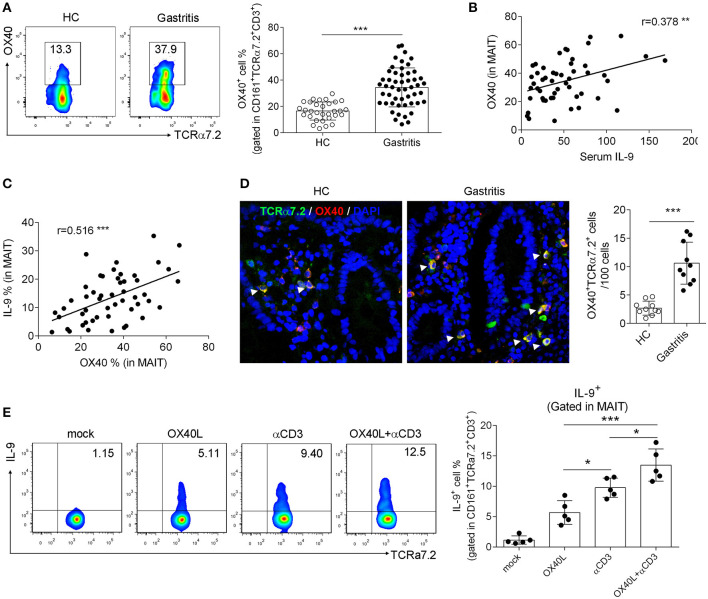
OX40 promoted IL-9 production by gastric mucosal MAIT cells in H. pylori-positive patients. Biopsies from gastric mucosa of H. pylori-positive patients (n = 51) and healthy controls (n = 35) were collected. (A) OX40 expression in MAIT cells was determined by flow cytometry. The correlations (B) between OX40 expression (in MAIT cells) and serum IL-9 level, and (C) between the percentage of OX40+ and IL-9+ MAIT cells were analyzed, respectively (n = 51). (D) Co-localization of OX40 and MAIT cells was assessed by immunofluorescence (n = 10). Antibodies against TCRα7.2 (Green), OX40 (Red), and DAPI (Blue) were used for staining. (E) MAIT cells were isolated from the gastric mucosa of H. pylori-positive patients (n = 5) and stimulated with 1 μg/ml CD3 activating Abs or 10 μg/ml recombinant OX40L protein. Three days later, IL-9 production by MAIT cells was determined. Data were from three independent experiments. Unpaired Student's t-test was used to compare the difference between HC and gastritis group. One way ANOVA was performed to compare multiple groups. *P < 0.05; **P < 0.01; ***P < 0.001.